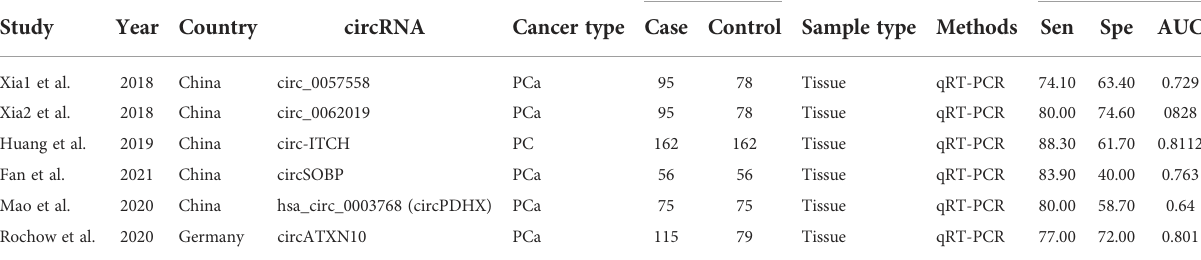
TABLE 1 Basic features of studies for diagnosis